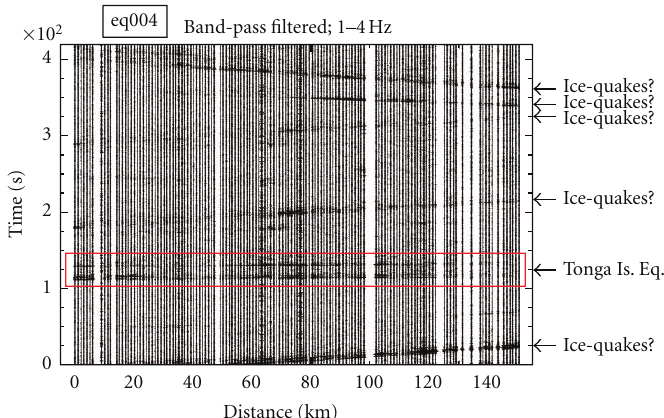
Figure 4: Band-pass filtered (1.0–4.0Hz) waveforms of the record section including teleseismic event (event#; eq004; Tonga Islands, indicated by red squared area). Many local events which appeared to be ice-quakes are clearly recognized. The vertical axis starts from 16:00 (UTC) on January 13, 2002. Seven minutes of the data length.